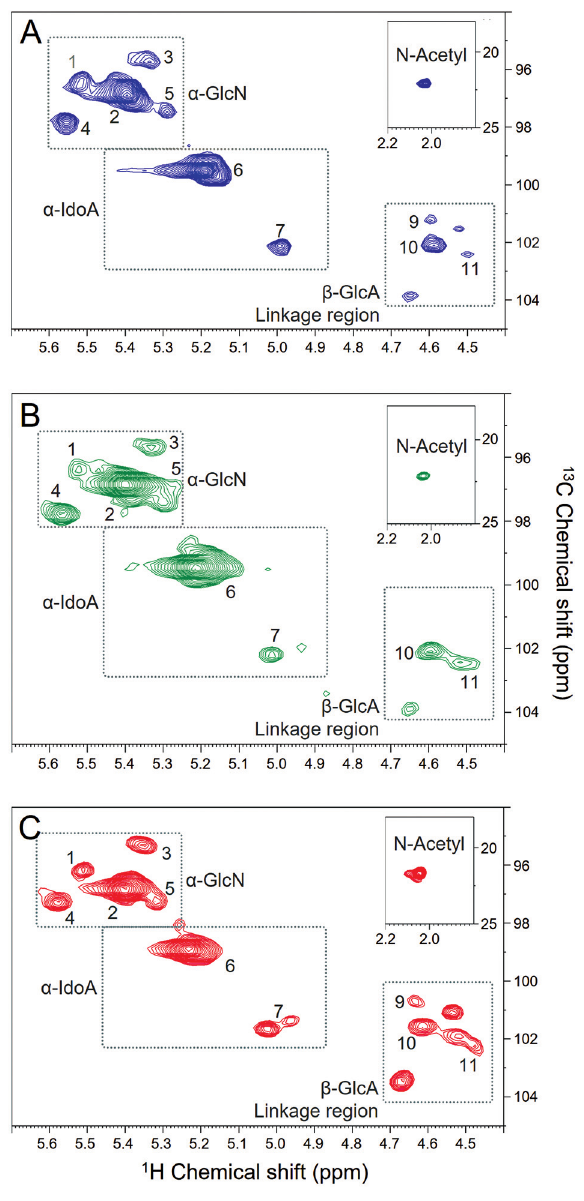
Fig.4 2D 1 H- 13 CHSQCNMRspectraofHOI(panelAinblue),HBL(panelBin green) and HPI (panel C in red). The numbers in the panels refer to the anomericsignalsofthestructuresdescribedinTable2.Thedottedsquaresin thePanelsenclosetheregionsofthespectracontainingtheanomericsignals of α -D-glucosamine ( α -GlcN), α -L-iduronic acid ( α -IdA) and β -D-glucuronic acid ( β -GlcA) þ units of the linkage region and CH3 of the N -acetyl group